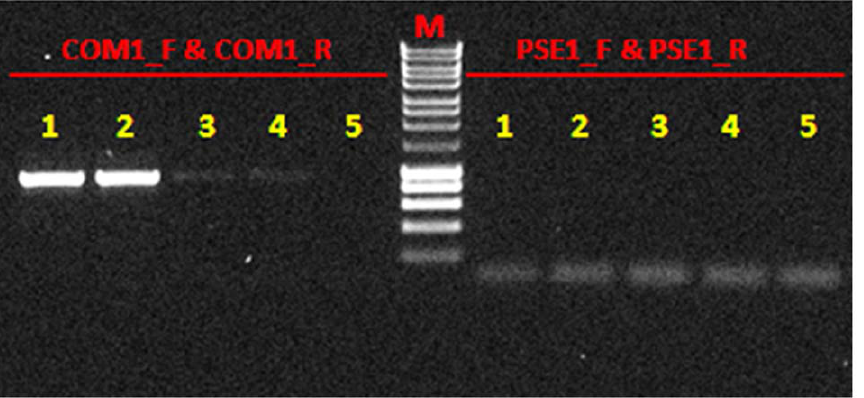
Figure 2. Naphthalene dioxygenase (NDO) PCR products. Two pairs of degenerate primers, COM1_F&COM1_R ( Comamonas -type), and PSE1_F&PSE1_R ( Pseudomonas -type) (Table 1) and different DNA templates: 1, 2 - 13 C-DNA; 3, 4 - 12 C-DNA; 5– blank control were used. M - DNA molecular weight Ladder.